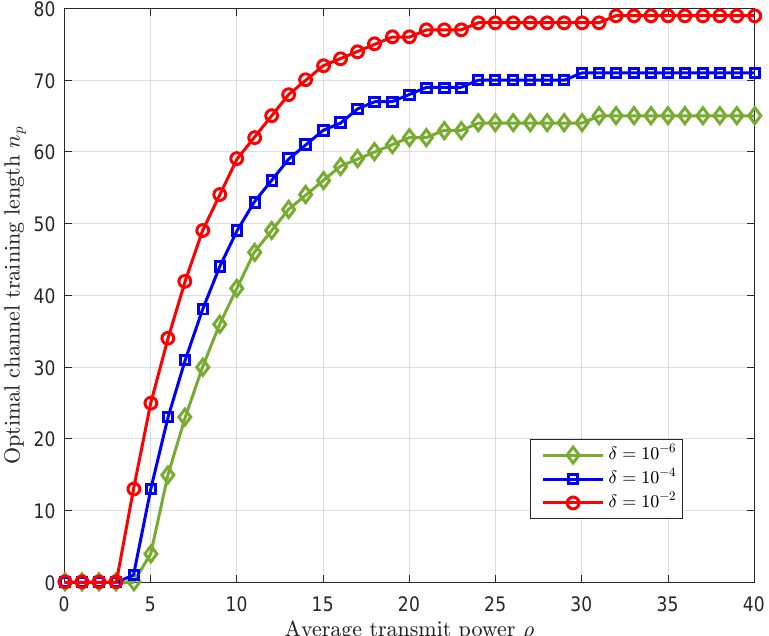
Figure 6. The optimal channel training length n p versus the average transmit power ρ with α = 0.5, n = 200, ¯ γ sd = 0 dB, and ¯ γ se = 0 dB, where the optimal channel training length is obtained without reliability constraint.